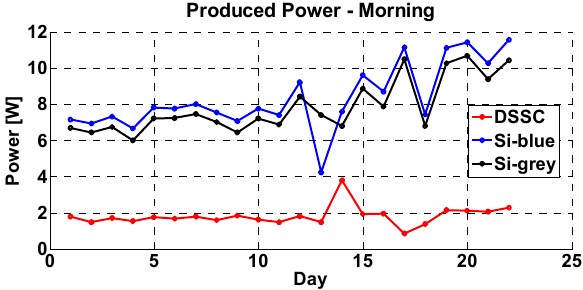
Figure 21. Morning power trends of the three generation systems.